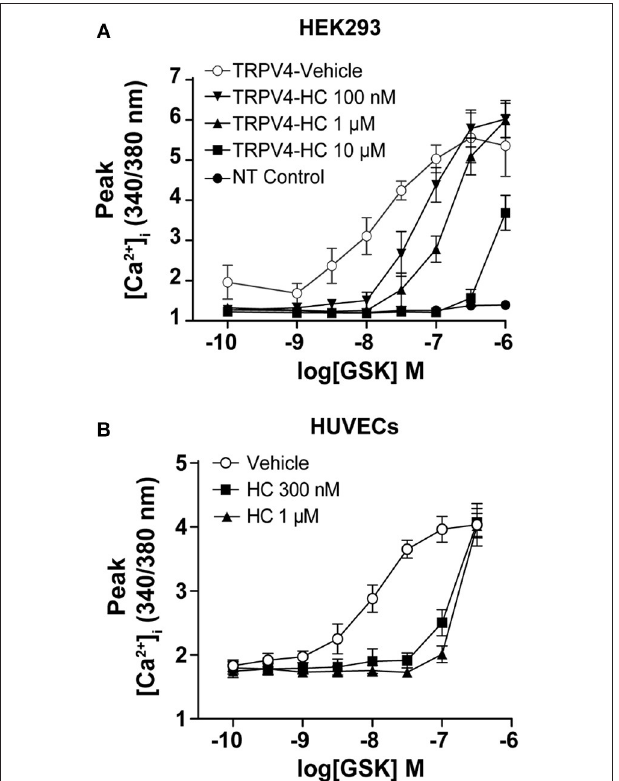
FIGURE 1 | GSK1016790A induced Ca 2 + influx in endothelial cells and HEK293 cells stably expressing TRPV4. Ca 2 + imaging showing that treatment with GSK1016790A induced Ca 2 + influx in (A) HEK293-TRPV4 cell line and (B) HUVECs and inhibition of TRPV4 with HC067047 abolished the GSK1016790A induced Ca 2 + influx in both cell types. Data are representative of 3–4 independent experiments and are presented as mean ± SEM. NT in (A) represents non-transfected parental HEK293